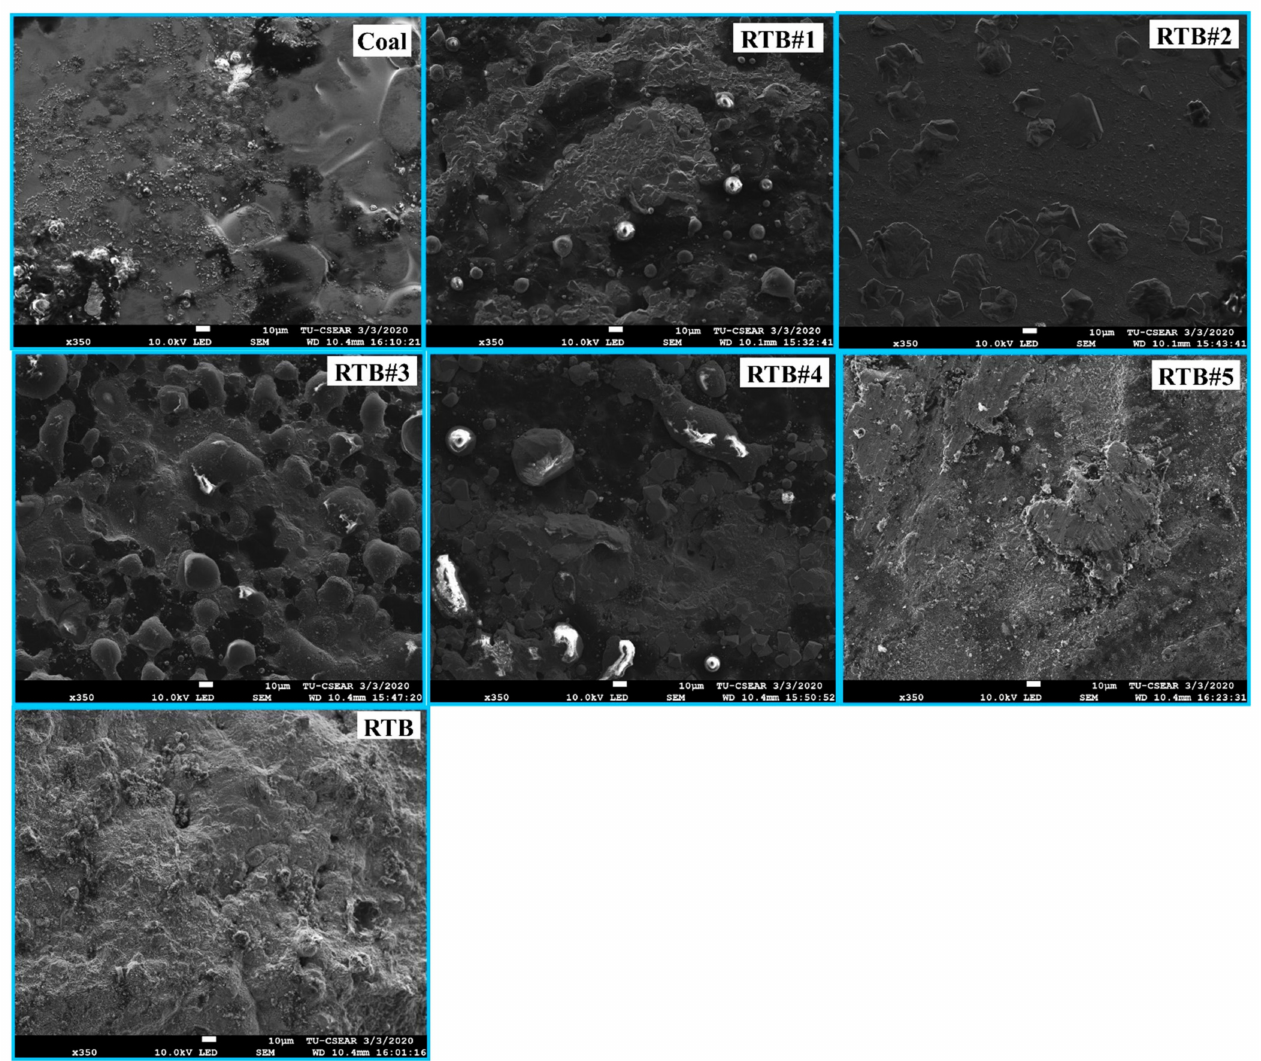
Figure 9. SEM micrograph ( × 350) at the surface of the metallic Fe droplets obtained after high-temperature interaction of the CCP for 30 min for all